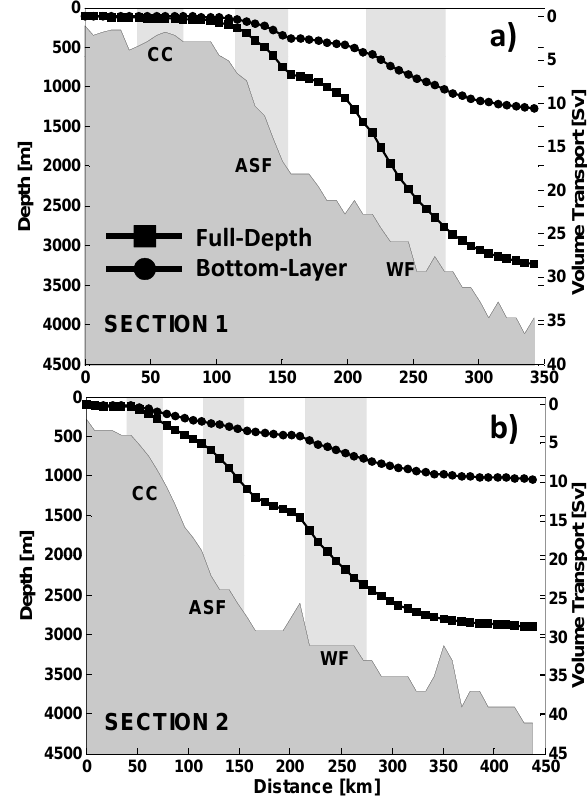
Fig. 15. Climatology of OCCAM (left) and SSM/I (right; from the National Snow and Ice Data Center ) sea ice concentration (%) dur- ing February: (a, d) 1988–2004, (b, e) 1988–1994, and (c, f) 1995– 2004.